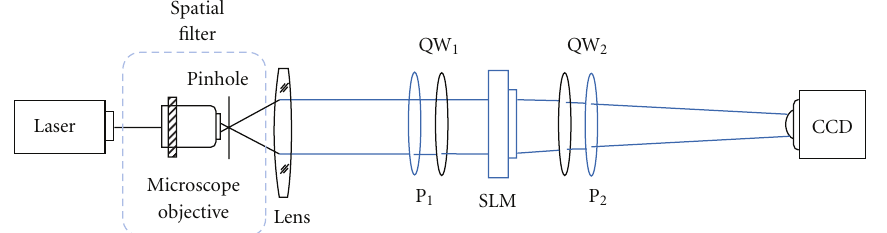
Figure 2: Experimental setup of Fresnel lens with embedded vortices; P 1 and P 2 : Polarizers, QW 1 and QW 2 : Quarter wave plates, SLM: Spatial light modulator, and CCD: